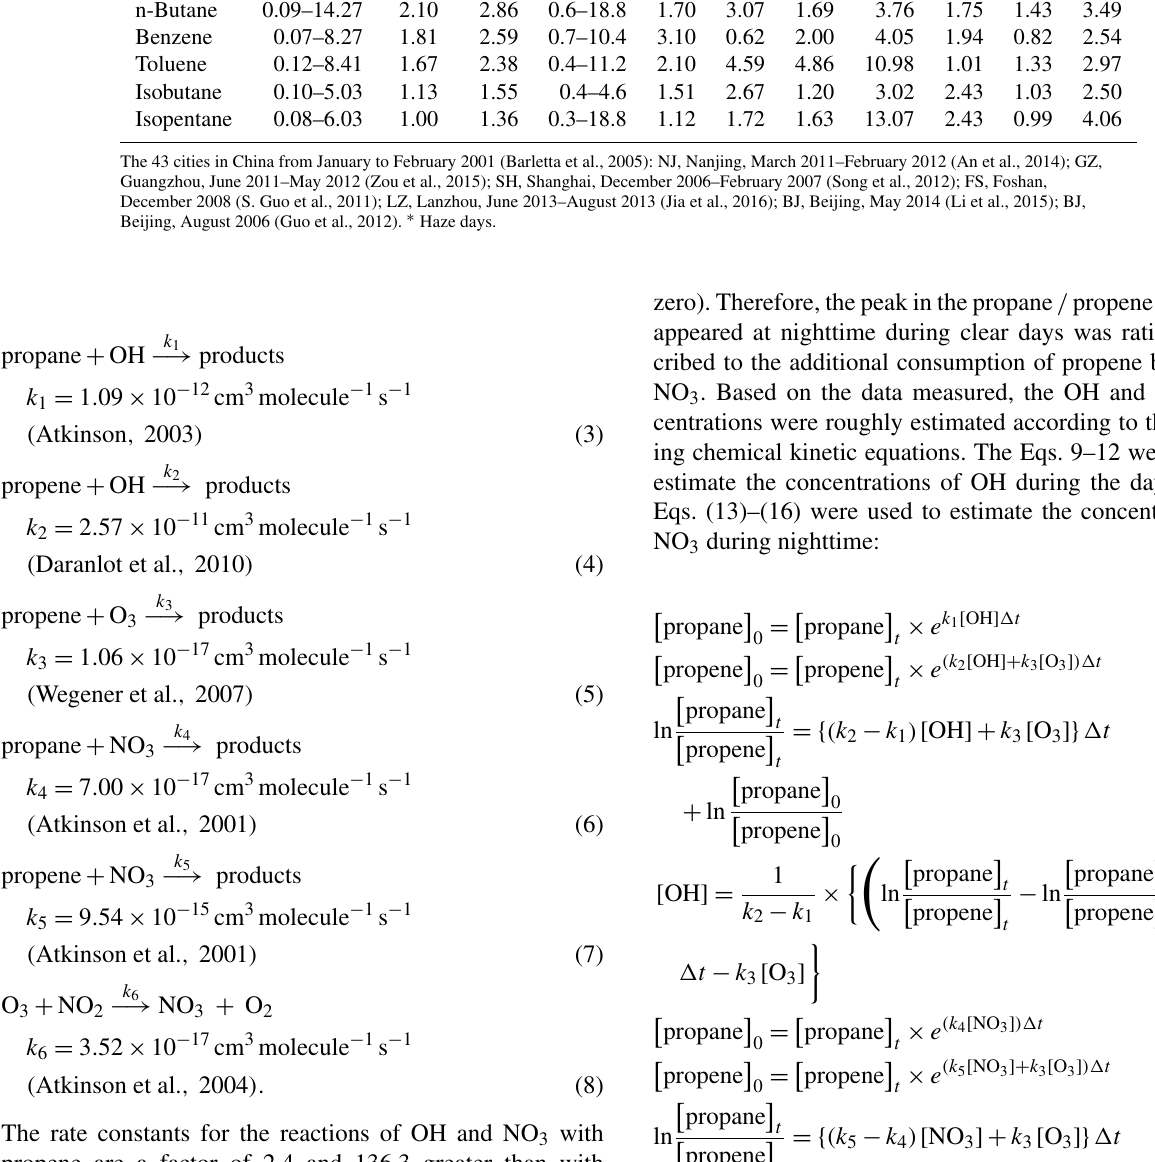
Table 3. Comparisons of the 10 most prevalent NMHCs in Beijing with other cities in China (ppbv). This study 43 cities NJ GZ SH FS ∗ LZ BJ BJ ∗ The range AVG Haze Ethane